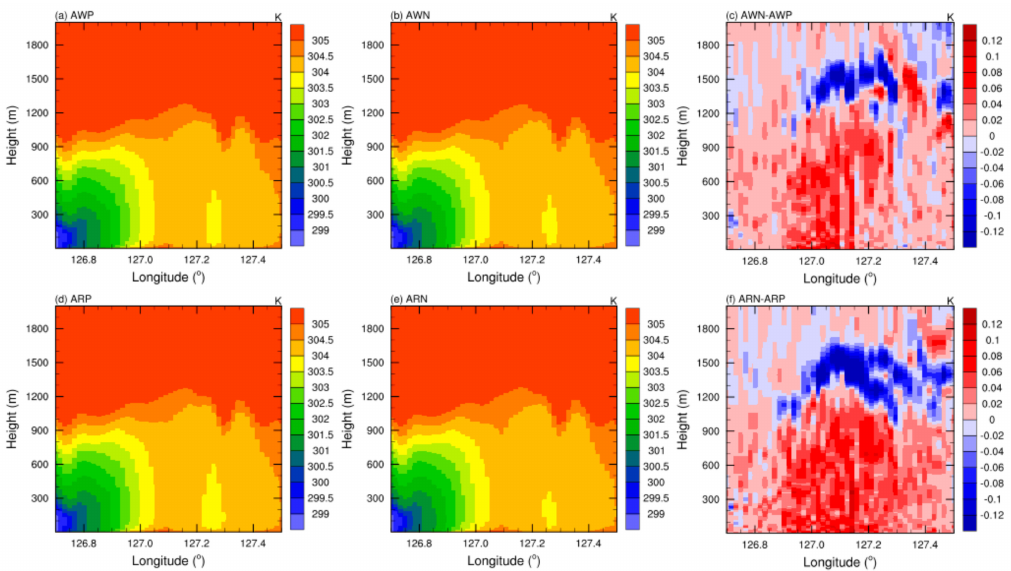
Figure 10. Vertical distribution of potential temperature at 37.33 ◦ N in ( a ) AWP, ( b ) AWN, ( c ) AWN-AWP, ( d ) ARP, ( e ) ARN, and ( f ) ARN-ARP.